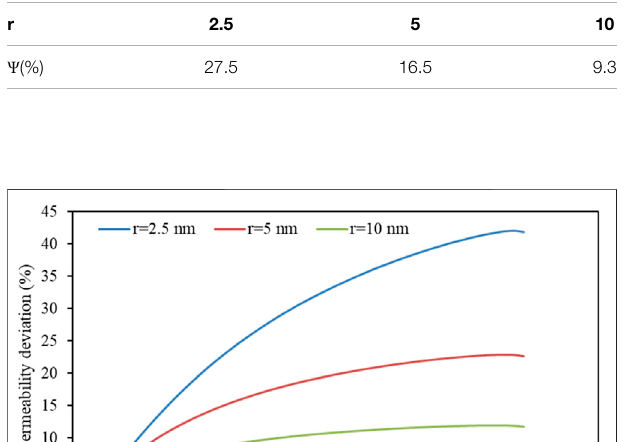
TABLE 7 | Average apparent permeability deviation for real and ideal gases for different pore radii.